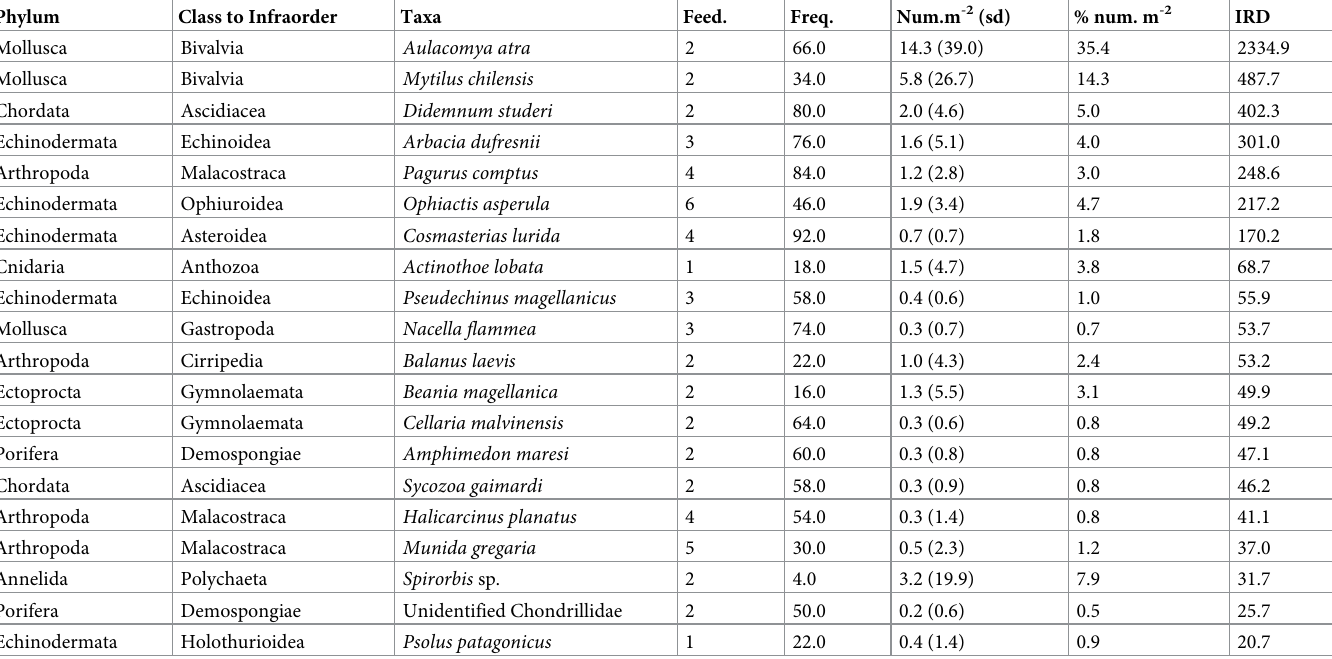
Table 1. Top twenty invertebrate taxa based on Index of Relative Dominance